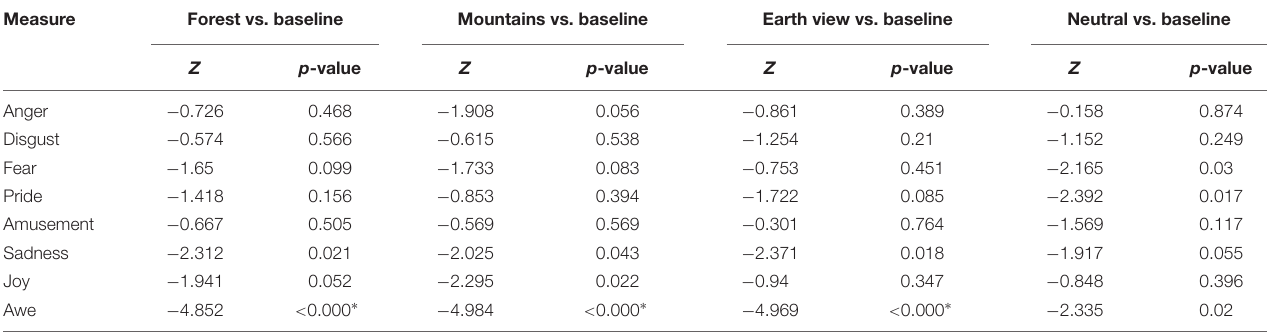
TABLE 2 | Significance levels for each condition compared to baseline using Wilcoxon test. Measure Forest vs. baseline Mountains vs. baseline Earth view vs. baseline Neutral vs. baseline